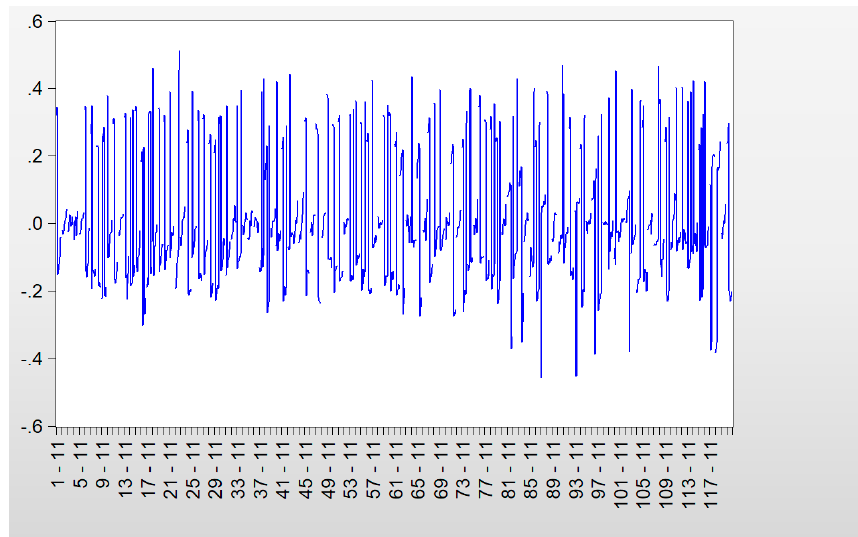
Figure 1. The influence of voter ownership concentration on the quality of board composition before the COVID-19 pandemic. Source: Author’s computations.